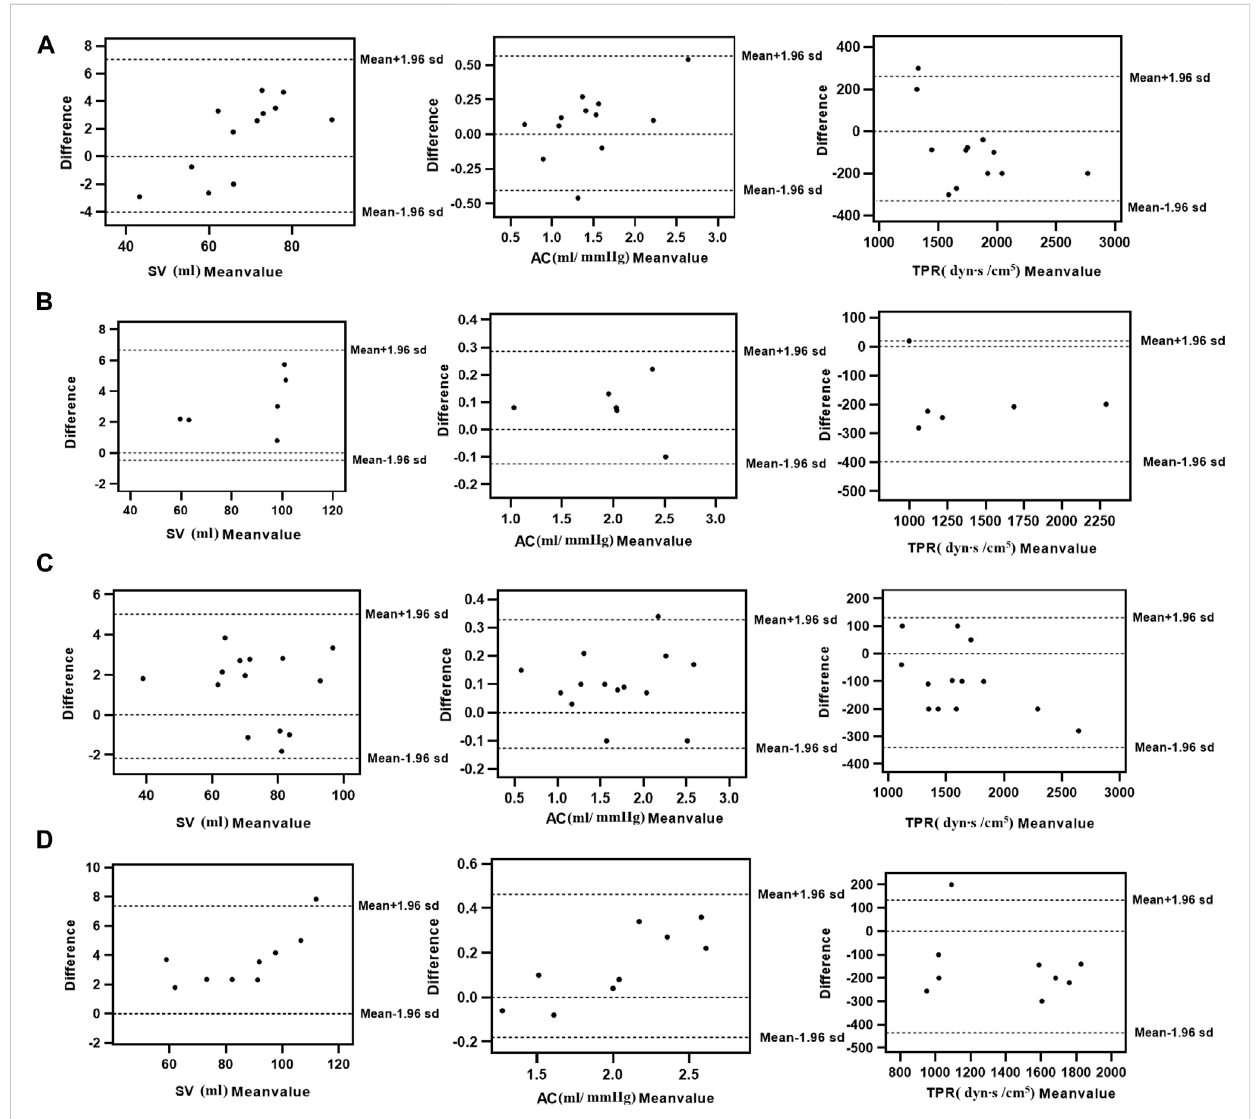
FIGURE 5 Consistency analysis between calculation and clinical measurements value of SV, TPR, and AC with cardiovascular diseases [ (A) Hypertension, (B) Atherosclerosis, (C) IASBPD10 – 15 mmHg,and (D) IASBPD > 15 mmHg];Therelationshipbetweentheaverage(horizontalaxis)andthedifference(vertical axis) is illustrated using scatter